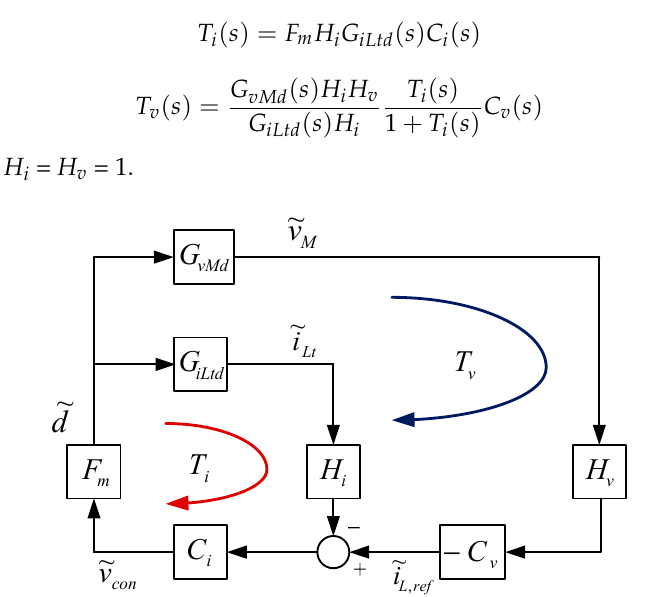
Figure 4. Block diagram for the closed-loop control scheme.